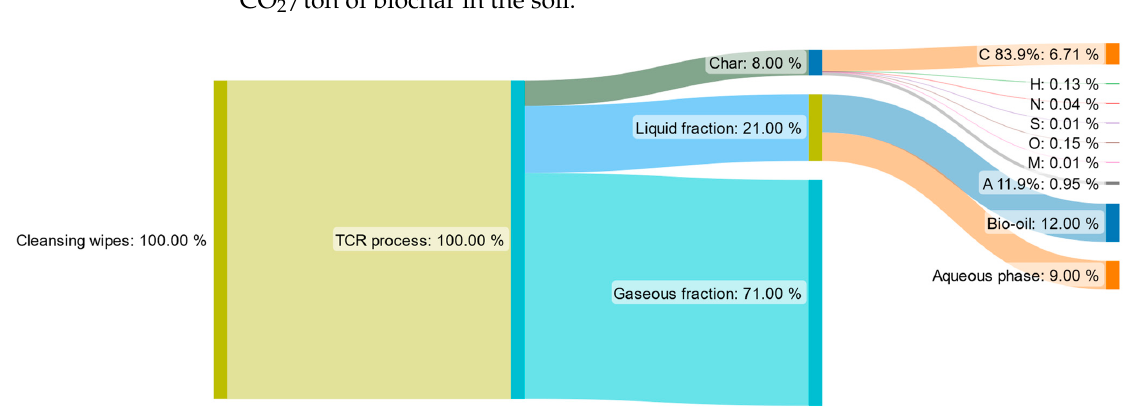
Figure 5. Sankey diagram for cleaning wipes as a feedstock in the TCR process (based on data from [11]).